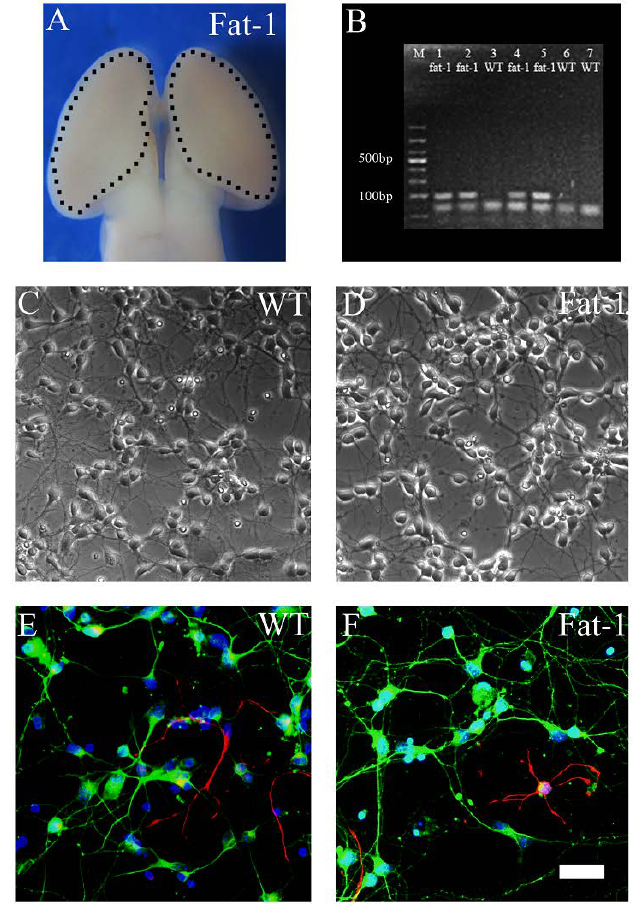
Figure 1. Identification of primary cultured neurons. Cultures were prepared from the cortex of E16.5 fat-1 and WT embryos and examined at 7 DIV. ( A ) An image showing the cortical tissue in the embryonic brain; ( B ) gel electrophoresis of PCR products using primers for fat-1 gene. Wild-type controls (lanes 3, 6 and 7) and positive fat-1 specimens (lanes 1, 2, 4 and 5); ( C , D ) examples of phase contrast images of cultured primary neurons; and ( E , F ) images showing immunostainning on WT and fat-1 neurons respectively ( Green , β -III tubulin; Red , GFAP; Blue , DAPI). Scale bar: 50 μm.